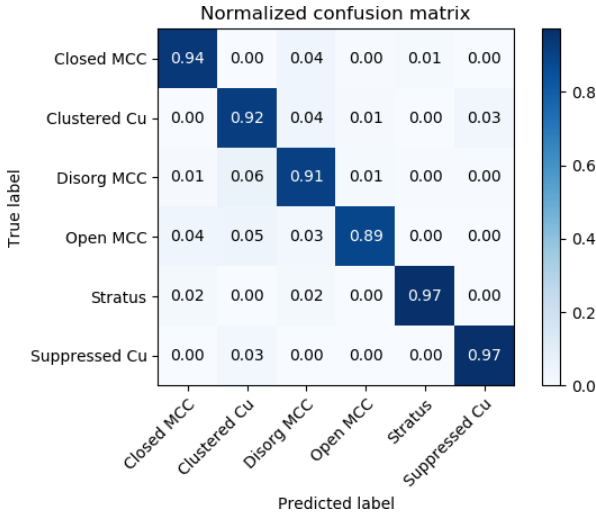
Figure 6. Confusion matrix of the model predictions on test